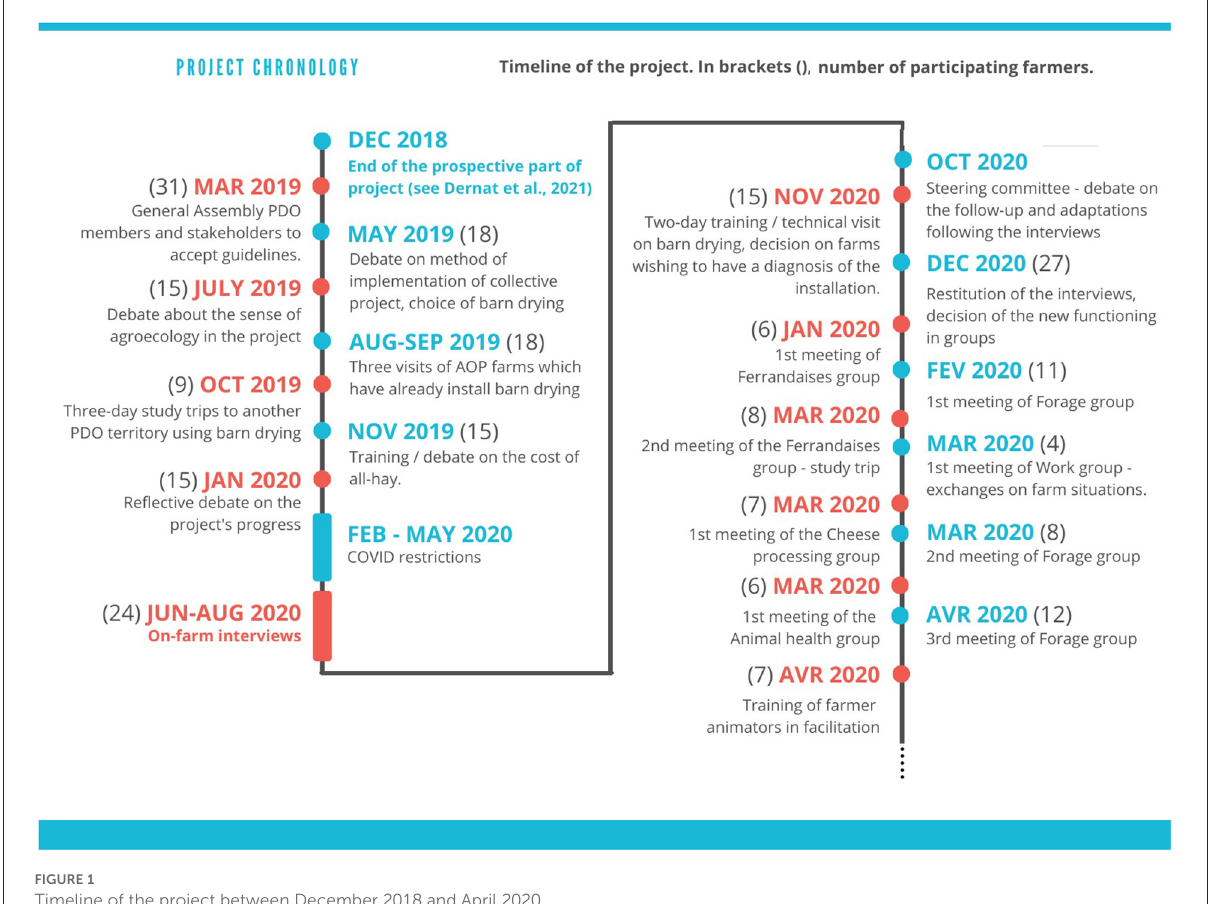
FIGURE1 Timeline of the project between December 2018 and April